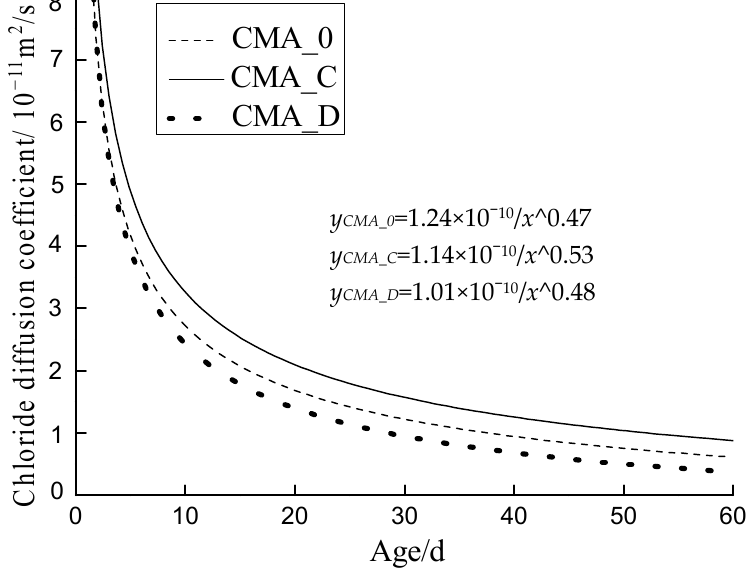
Figure 8. Relationship between age of concrete and chloride diffusion coefficient.